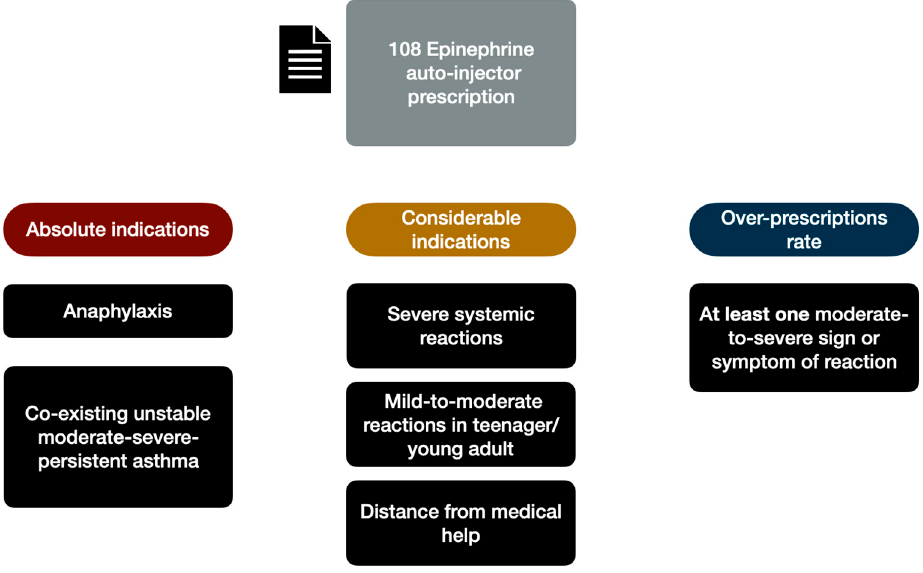
Figure 1. Epinephrine appropriateness prescription based on EAACI guideline [15].